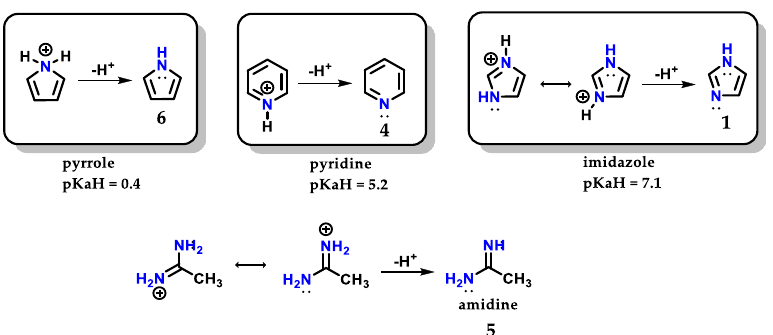
Figure 4. Protonated structures of pyrrole 6 , pyridine 4 and imidazole 1 , with their respective pKaH values and the structure of protonated amidine 5 compared to imidazole.